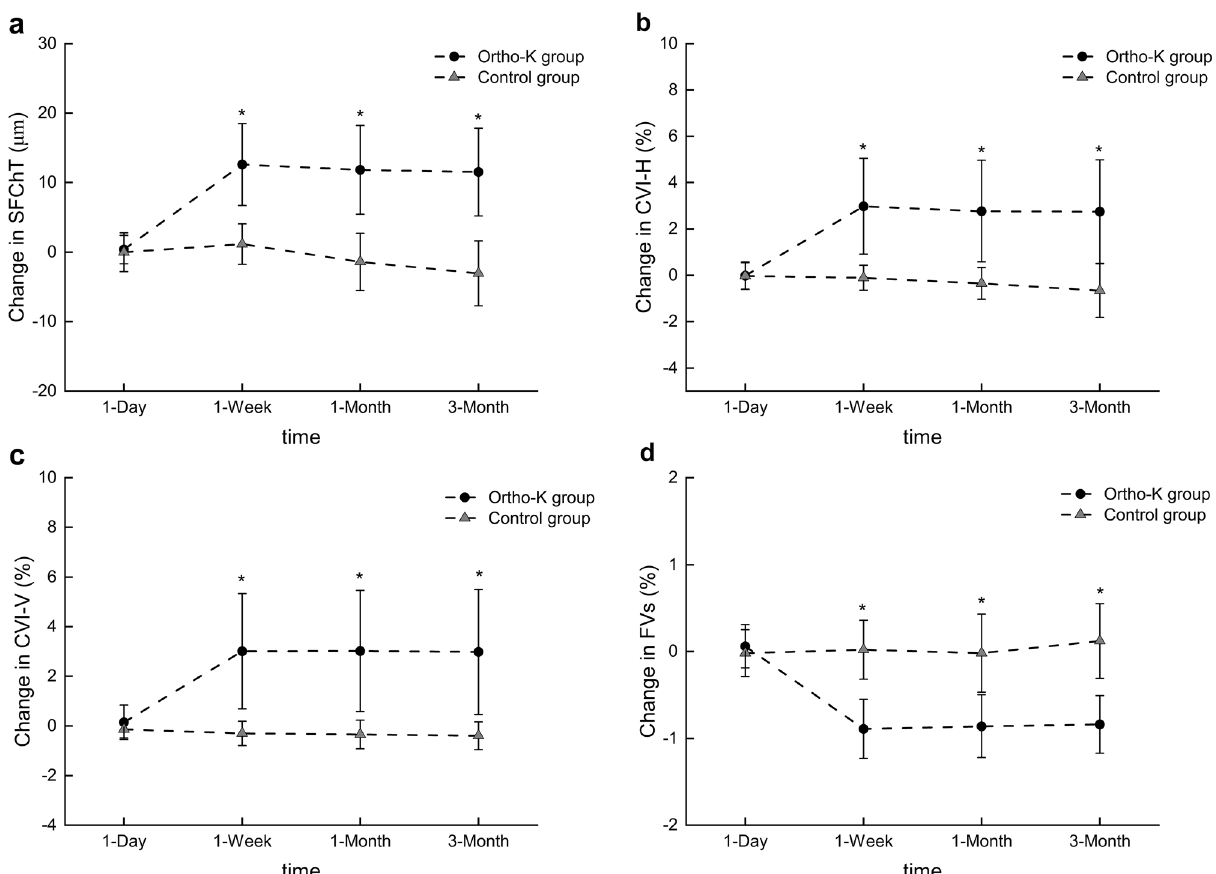
Figure 2. Change in the SFChT, CVI on the horizontal and vertical scans and FV% during the 3 months of follow-up between the two groups. In the Ortho-K group, the SFChT and CVI on the horizontal and